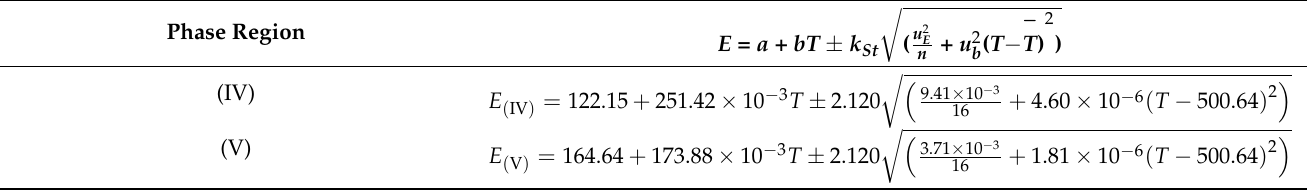
Figure 6. EMF versus temperature obtained with the ECCs incorporating PE in the phase regions (IV) –red open circles and (V) –closed square. Table 6. EMF vs. temperature relations for the type (A) ECCs in the (IV) and (V) phase regions of the Fe–Ag–Te–Ge system, in the temperature range between 482 and 519 K. The coefficients a and b were determined through linear least squares analysis of the measurements, n is the number of successful experimental points, k St is Student’s coefficient with a level of confidence of 95%.